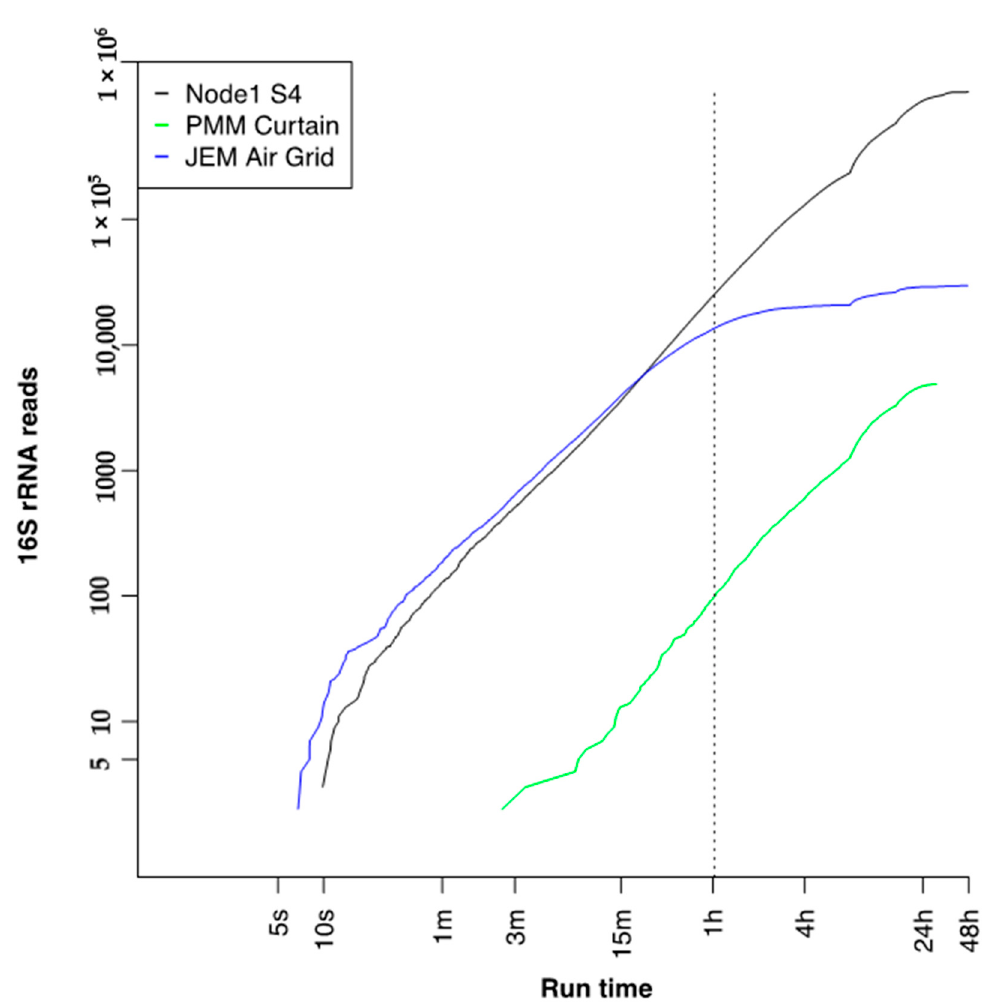
Figure 7. 16S reads accumulated over time per three swab-to-sequencer runs onboard the International Space Station. The dotted line represents time when the same top suggested species diversity was recorded as at completion of the run (Supplemental Figure